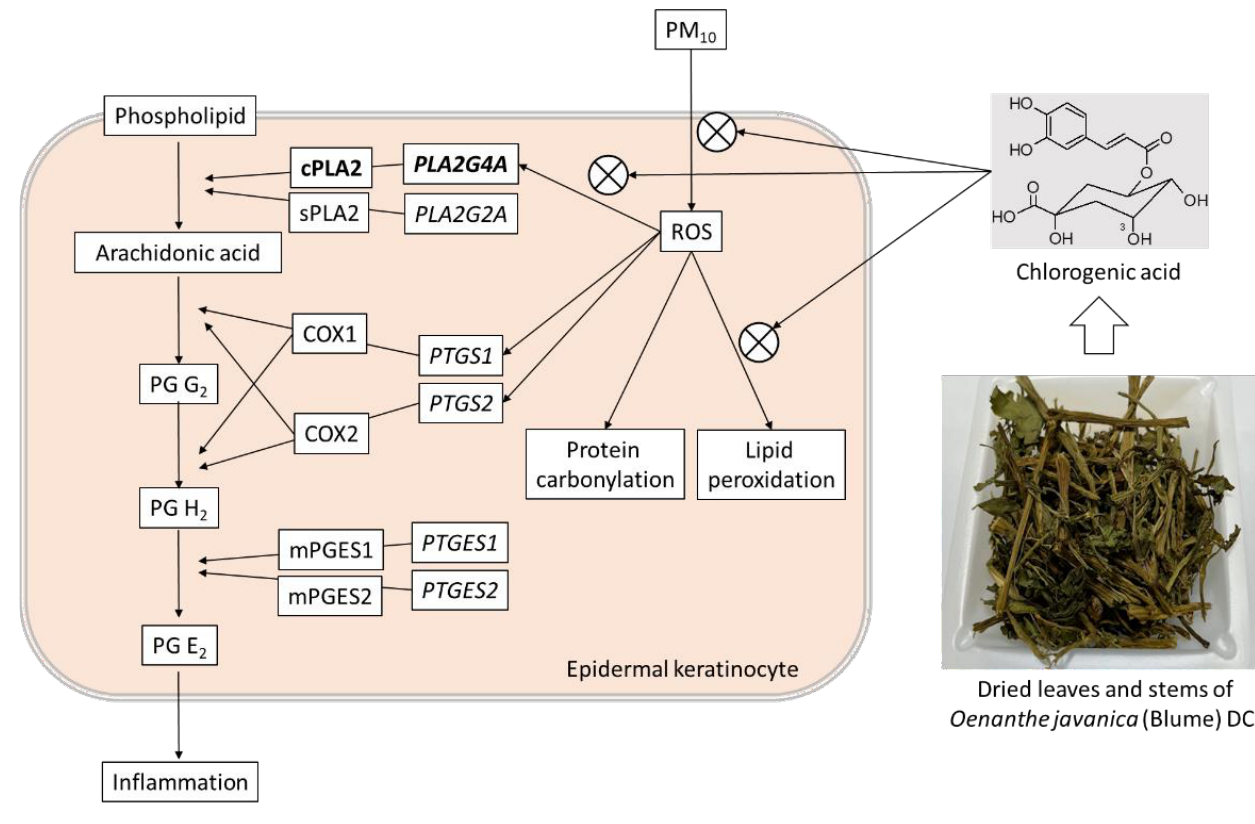
Figure 10. Antioxidant and anti-inflammatory effects of chlorogenic acid in HaCaT keratinocytes exposed to PM 10 . PM 10 increased ROS production and lipid peroxidation. It also increased PG E 2 production through the enhanced expressions of PLA2G4A mRNA and cPLA2 protein. These changes were attenuated ( ⊗ ) by chlorogenic acid, a main component of